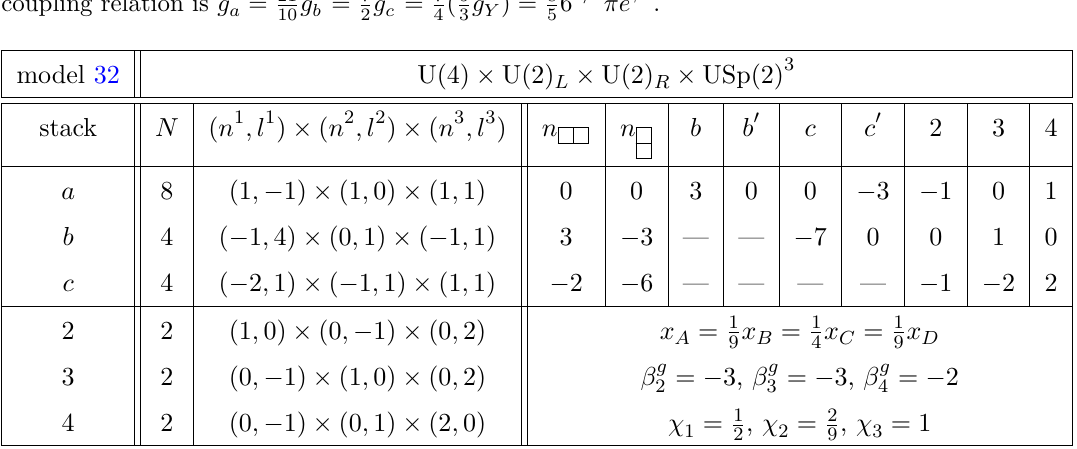
Table 32 . D6-brane configurations and intersection numbers of Model 32, and its MSSM